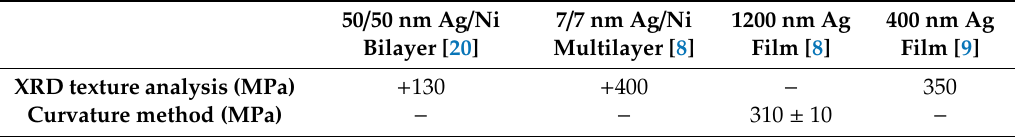
Figure 8. Strain at different depths . Table 4. The residual stress measurement results of Ag thin films compared with the values obtained from other